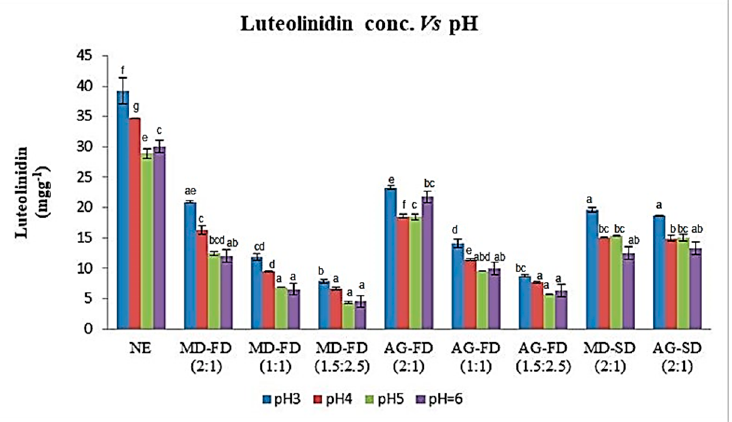
Figure 3. The concentration of luteolinidin (mg g − 1 ) for the red dye extract non-encapsulated (NE) and extracts encapsulated with maltodextrin (MD) and Arabic gum (AG) obtained by freeze-drying (FD) and by spray-drying (SD) (mean ± SD), and dispersed at different pH values (3–6). Bars with the same letters are not significantly different at 5%.